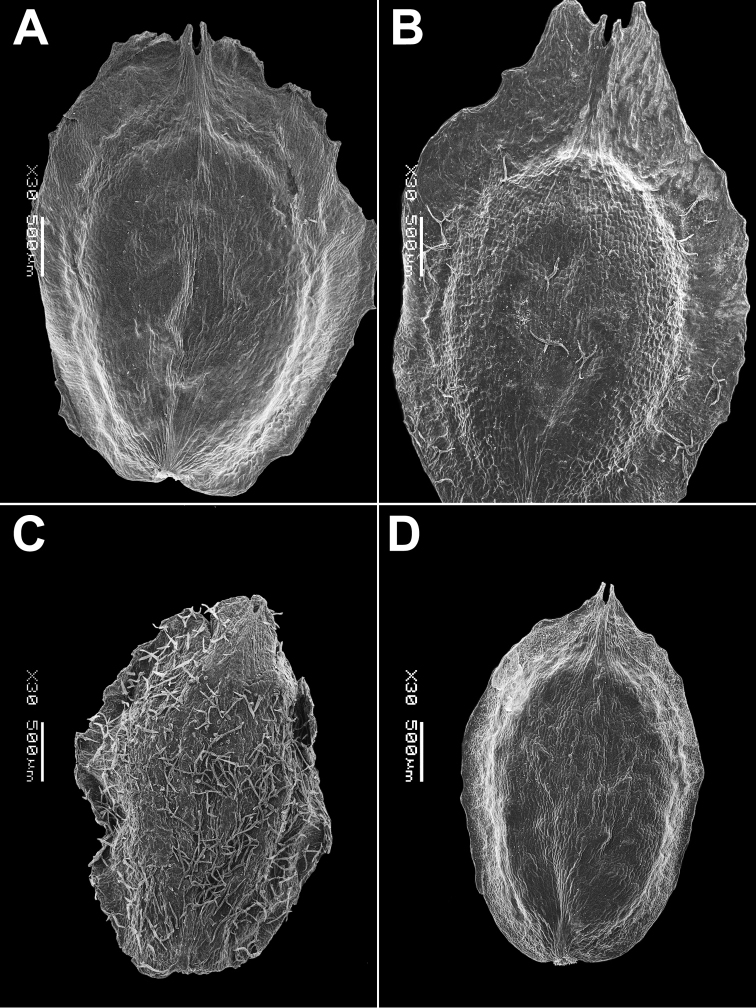
SEM micrographs of Corispermum fruits: AC.lhasaenseBC.lepidocarpumCC.gelidumDC.tibeticum. Magnification: 30×.